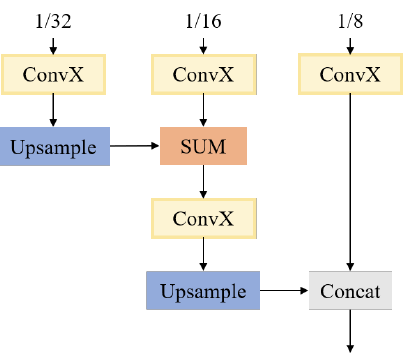
Figure 7. Three-level hierarchical module